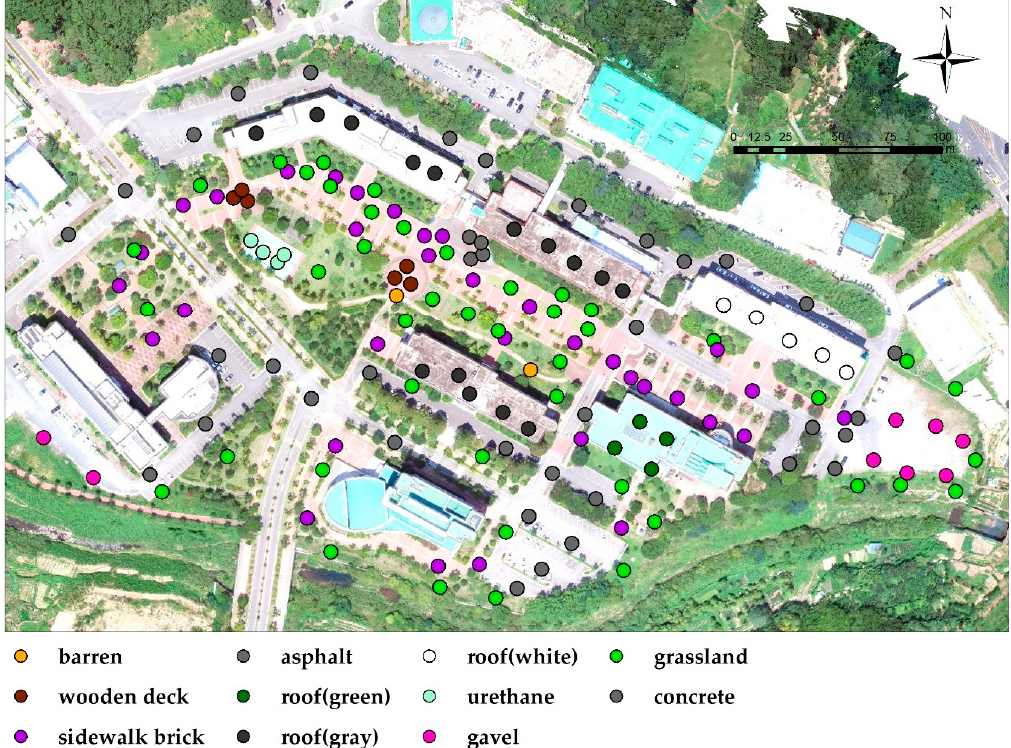
Figure 2. Image of measurement points, which are color-coded by land cover type.